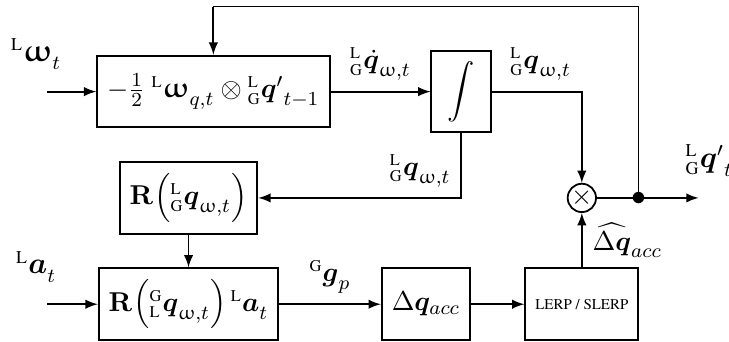
Figure 2. Block diagram of the complementary filter for IMU implementation (no magnetometer data).